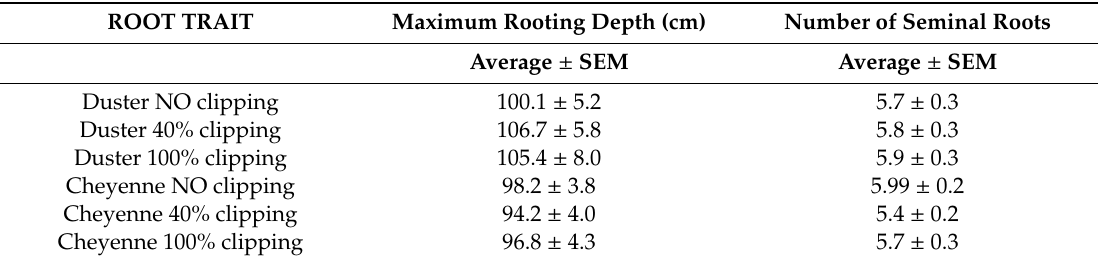
Table 3. Maximum rooting depth and number of seminal roots were not a ff ected by defoliation. The first two rows of the table specify root traits and statistics of the mentioned traits (average ± standard error of the mean (SEM)). The first column on the left represents di ff erent treatments applied. There were not statistically significant di ff erences among the treatments ( p <